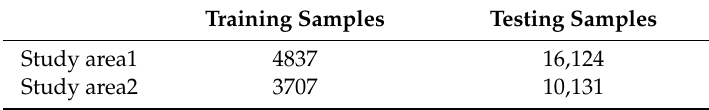
Table 3. The detail information of two study areas used in